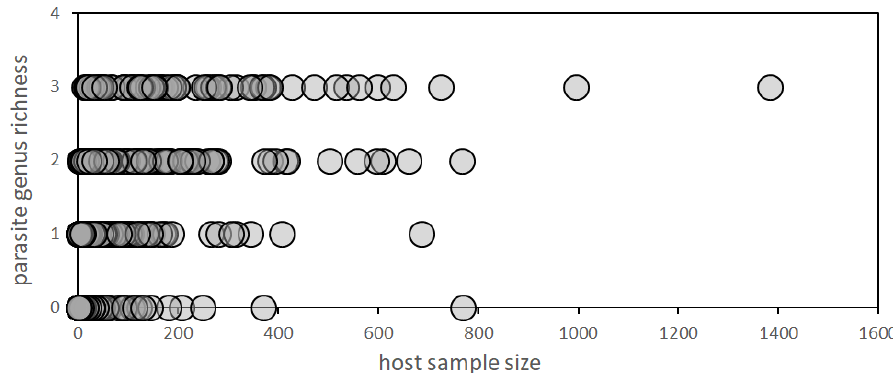
Figure 2. The relationship between hummingbird sample size and louse genus richness.